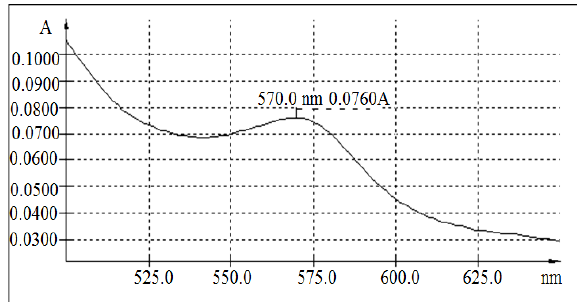
Fig. 2. Absorption spectrum of glucose solution P (3.3·10 -6 μg) in an acidic medium with α-naphthol